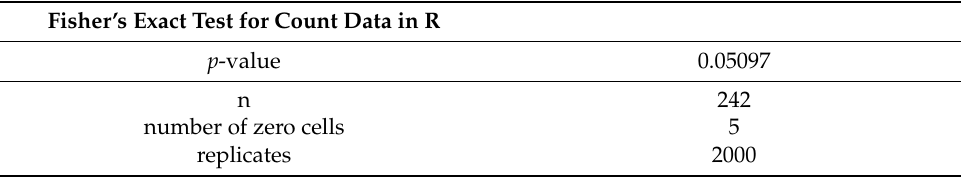
Figure A1. Ripley’s K function(K-r) with border correction (K-bord), isotropic correction (K-iso), and translation correction (K-trans). K(theo) is the theoretical Poisson expected curve. Source: Authors’ own with R software. Table A1. Fisher’s exact test for count data (n = 242